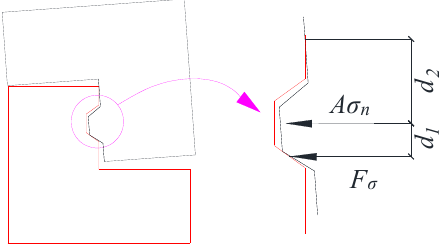
Figure 12. The key interface state after the slipping of the key.